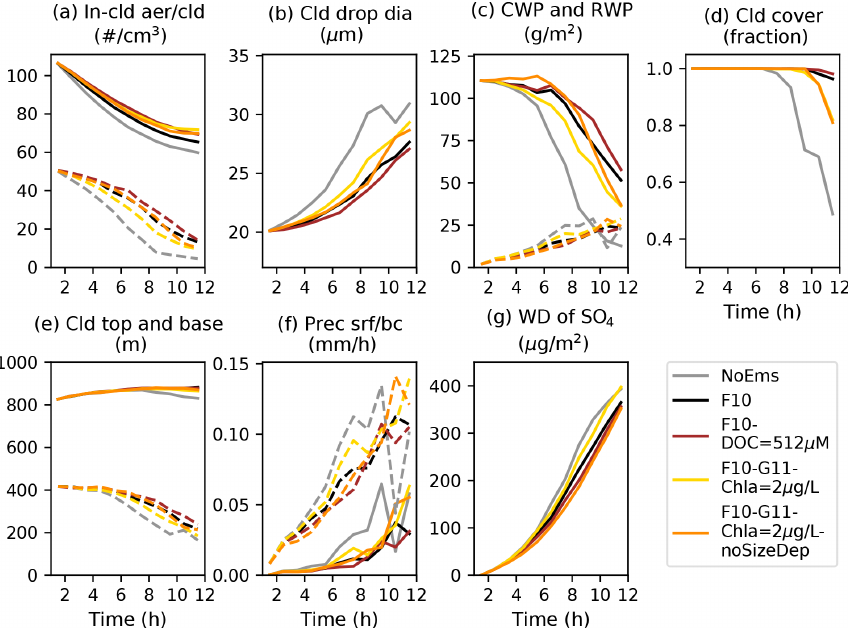
Figure 5. Impact of dissolved organic carbon-dependent enhancement of emission flux (brown) and organic aerosol fraction impact through hygroscopicity change (yellow – size-dependent scheme, orange – maximum organic fraction applied to all sizes). Panels are the same as Fig.